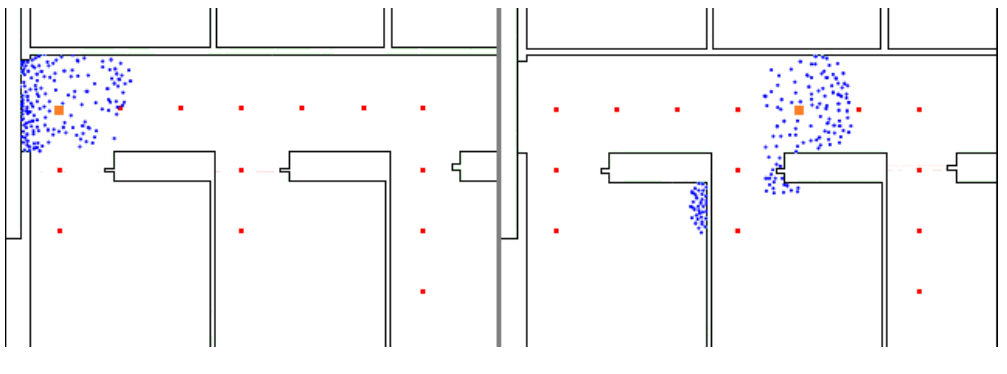
Figure 12. IMU data error representation using the particle filter and the model-based navigation. Cloud of particles after 9 steps ( left ), 21 steps ( right ). The points represent particles. The current true user position is marked by the bigger square. Every particle that crosses a wall has been